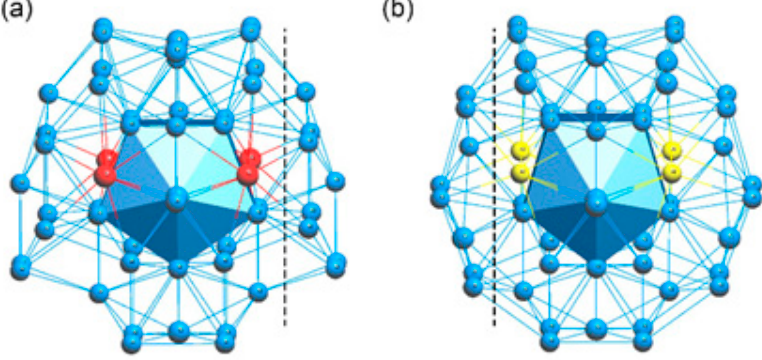
ε - Al µ - Al 4 Cr and ( b ) 4